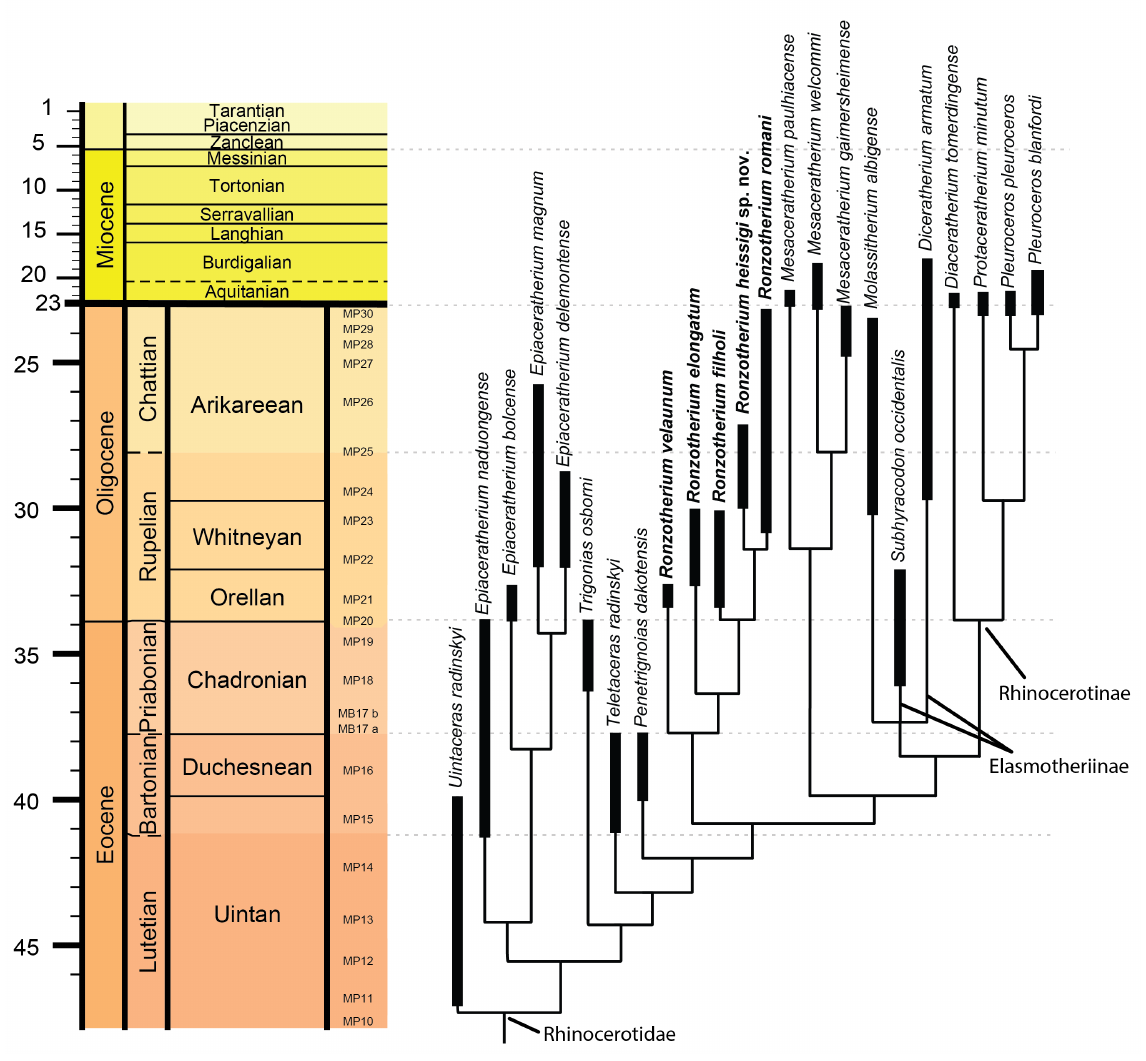
Fig. 28. Cladogram of Rhinocerotidae Owen, 1845 calibrated in time. Bold lines indicate the temporal range of each terminal. Temporal scale for the Miocene and younger periods has been compressed and differs from the Eocene and